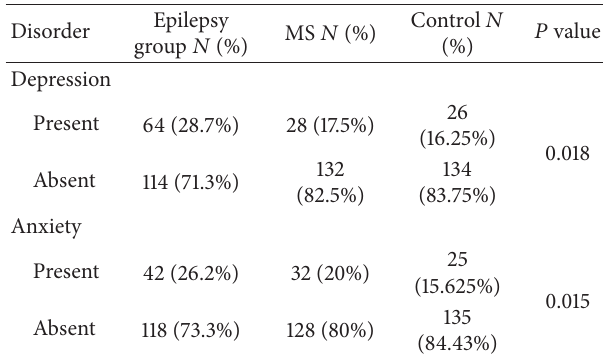
Table 2: Rates of depression and anxiety among PWE, MS, and control